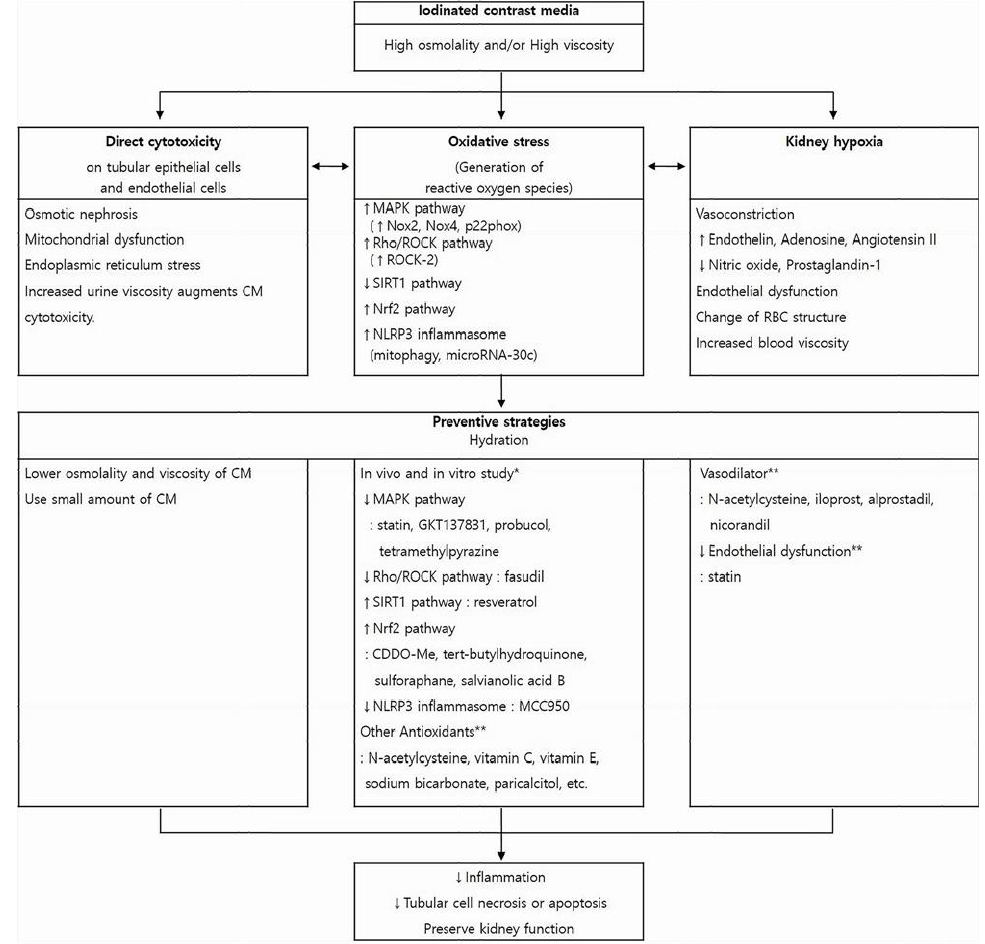
Figure 1. Pathophysiology of contrast-induced nephropathy (CIN) and promising strategies to preserve kidney function. Iodinated CM has direct cytotoxic effect on endothelial cells and renal tubular epithelial cells, induces vasoconstriction causing hypoxia in the outer medulla, and enhances the generation of reactive oxygen species. These changes influence one another and ultimately lead to kidney injury. Each box contains underlying mechanisms relevant to those three pathways. Hydration is the mainstay of CIN preventive strategies and can reduce harmful effect of CM in all three aspects. Other previously reported preventive measures and pharmaceutical agents are presented with regard to each pathogenic process. * These pharmaceutical agents have been studied in in vitro and in vivo experiments to reduce oxidative stress, that is, to reverse each pathogenic pathway.